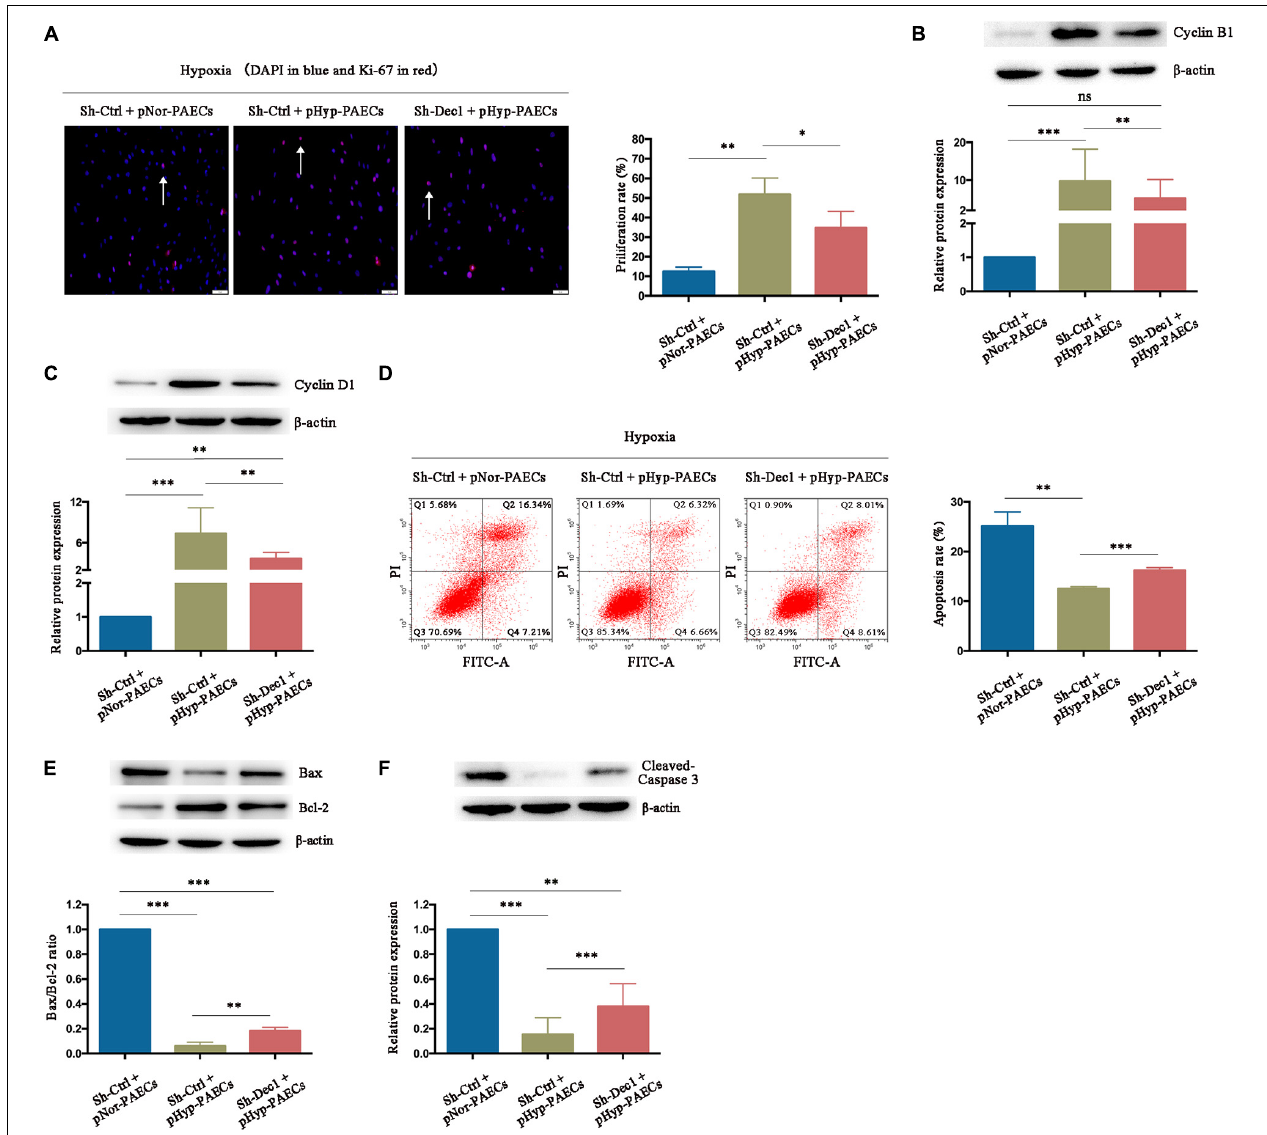
FIGURE 5 | Hypoxia promotes the PAH phenotypes of PAECs by induction of Dec1. Human normal PAECs (hnPAECs) were transfected with Dec1–shRNA (Sh-Dec1) or scrambled RNA (Sh-Ctrl) and then preconditioned with normoxia (21% O 2 , pNor-PAECs) or hypoxia (3% O 2 , pHyp-PAECs) for 1 week. Next, these cells were assessed proliferation and apoptosis by immunofluorescence staining of Ki-67 and flow cytometry under hypoxia (3% O 2 ), respectively. In proliferation assay, Ki-67-positive cells (red) with nuclear DAPI counterstain (blue) indicated the proliferating cells. In apoptosis map, cells were divided into four subpopulations: necrotic cells (Q1: annexin V FITC–/PI+), late apoptotic cells (Q2: annexin V FITC+/PI+), live cells (Q3: annexin V FITC–/PI–), and early apoptotic cells (Q4: annexin V FITC+/PI–). The proliferative (Cyclin B1 and Cyclin D1) and apoptotic factors (Bax, Bcl-2 and cleaved-caspase 3) were also detected by western blot. (A) Immunofluorescence staining of Ki-67 (left part, scale bars = 50 µ m) and the proliferation rate (right part). (B,C) The expressions of Cyclin B1 (B) and Cyclin D1 (C) . (D) Flow cytometry (left part) and the apoptosis rate (right part). (E,F) The expressions of Bax, Bcl-2 (E) , and cleaved caspase 3 (F) . One-way ANOVA test was applied for statistical analysis. Data are represented as mean ± SEM. Experiments were repeated for three independent times. ∗ p < 0.05; ∗∗ p < 0.01; ∗∗∗ p < 0.001.